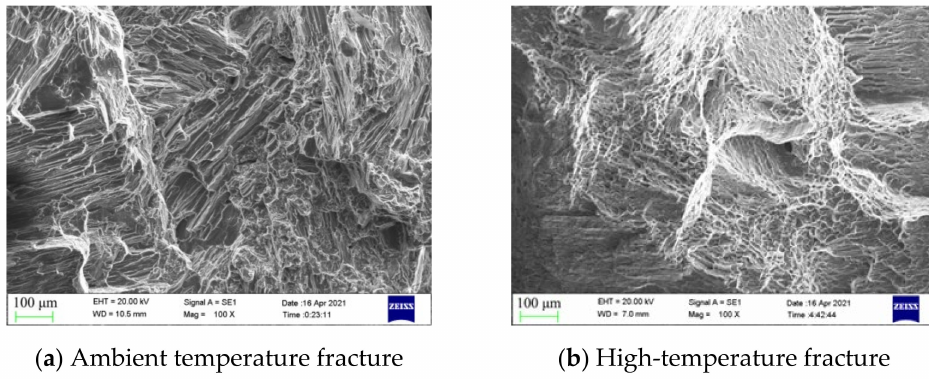
Figure 11. Fracture morphology of matrix magnesium